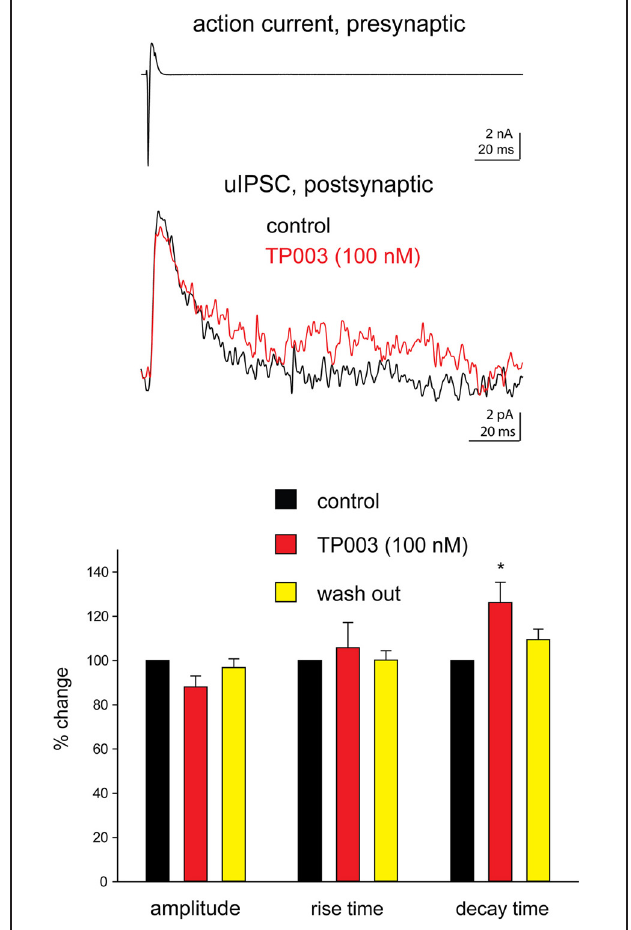
FIGURE 2 | The α 3 subunit selective agonist TP003 increases the decay time constant of Imp-mediated uIPSCs. All experimental conditions are as in Figure 1 . Upper traces: in the case illustrated, the decay of the uIPSCs, fitted with one exponential, increased from 14.6ms to 19.3ms during the application of 100nM TP003. The peak amplitude was 11.8pA before and 9.9pA during TP003; the rise time was 1.3ms before and 1.1ms during TP003. Lower graph: summary histograms of normalized peak amplitude, 20–80% rise time and decay time constant of the uIPSCs in control ( n = 7), 100nM TP003 ( n = 7), and wash out ( n = 3); ∗ Refers to p < 0 . 05, Wilcoxon-signed ranks